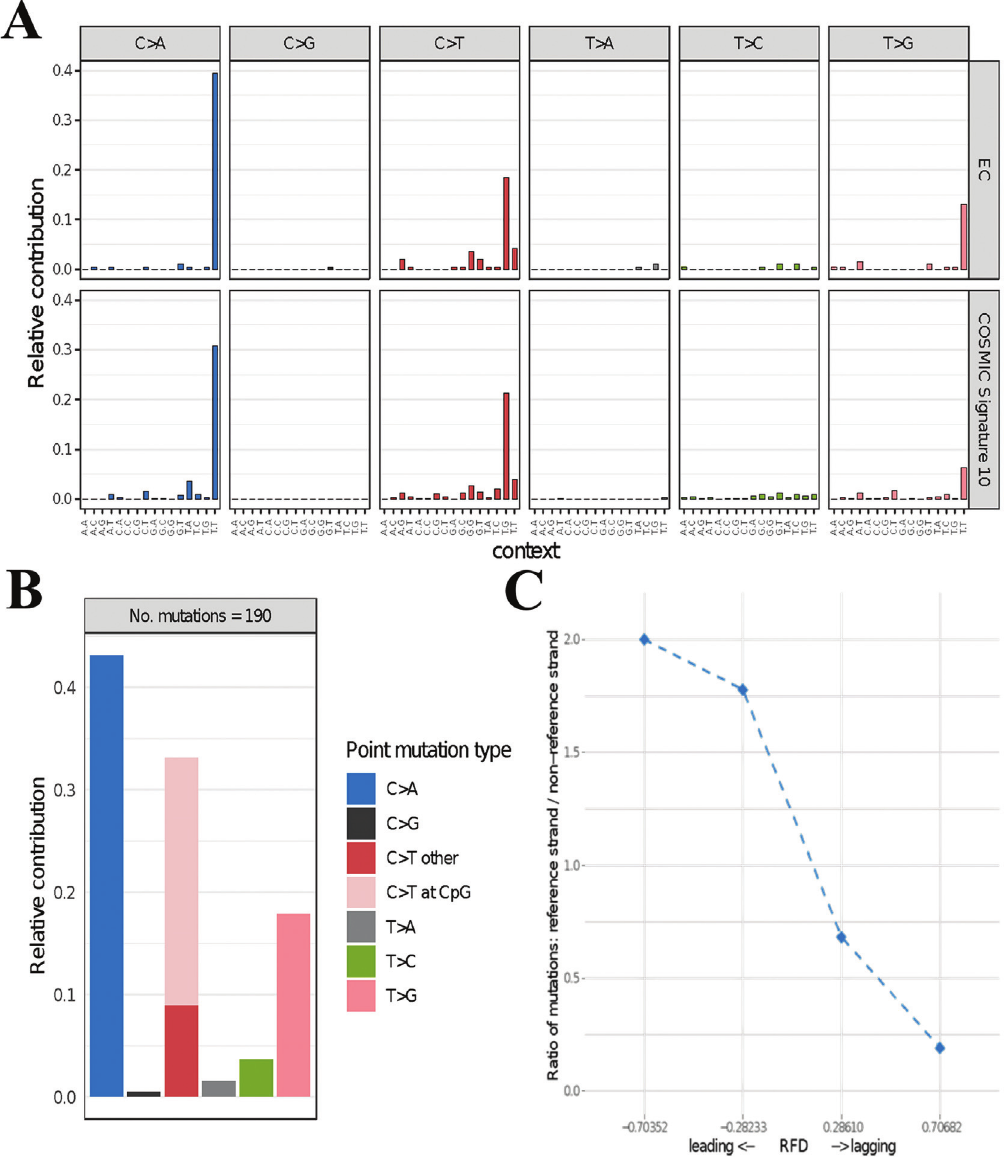
Figure 2 - Mutational profile based on targeted sequencing data of a 63 cancer-related gene panel. (A) mutational signature extracted from the endometrial carcinoma in comparison to the COSMIC signature 10. (B) relative contribution of each point mutation type to the total amount of somatic mutations. (C) Strand bias analysis showing a predominance of mutations on the leading strand. EC, endometrial